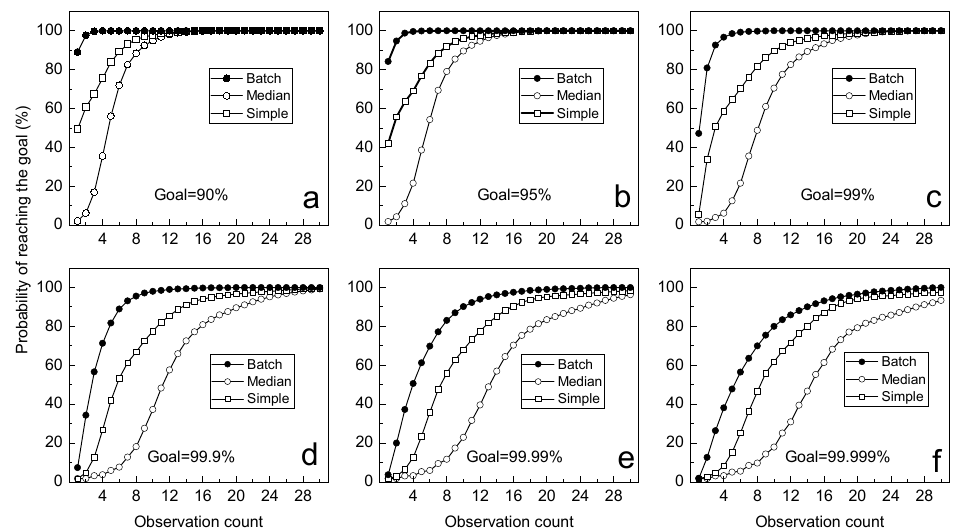
Figure 5. Comparison of the success rates of the three compositing algorithms for the 9331 tiles with different PATHs/ROWs in 2019. There are separate integrity goals ranging from 90% to 99.999% for each of the six subplots ( a – f